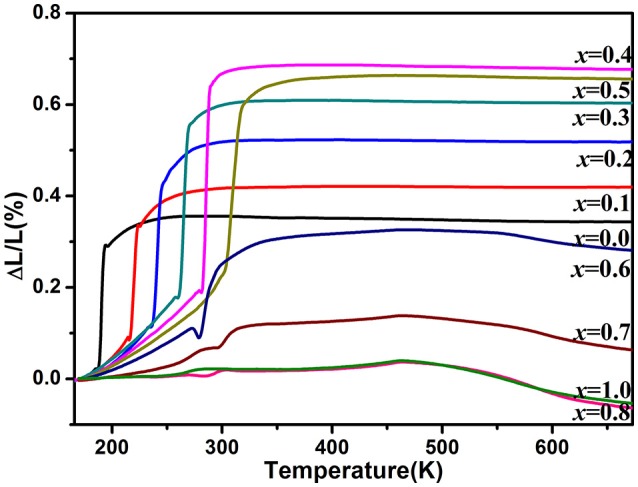
Variations of relative length of the solid solutions of HfMg1−xZnxMo3O12 with increasing temperature from 170 to 673 K.